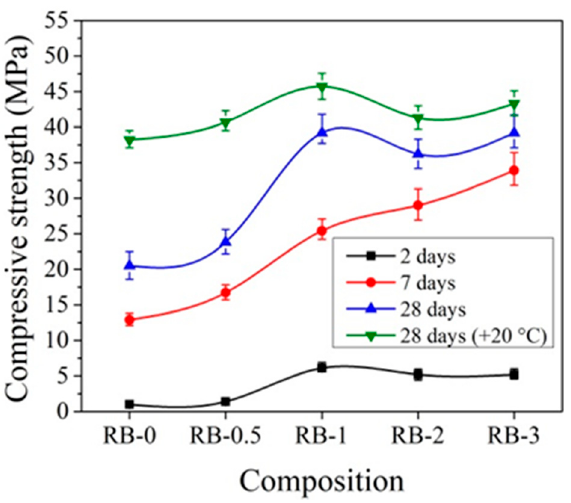
Figure 15. Compressive strength of concrete with CEM IIR samples at − 5 °C initial curing (28 days (+20 °C)—reference samples prepared and cured at +20 °C).